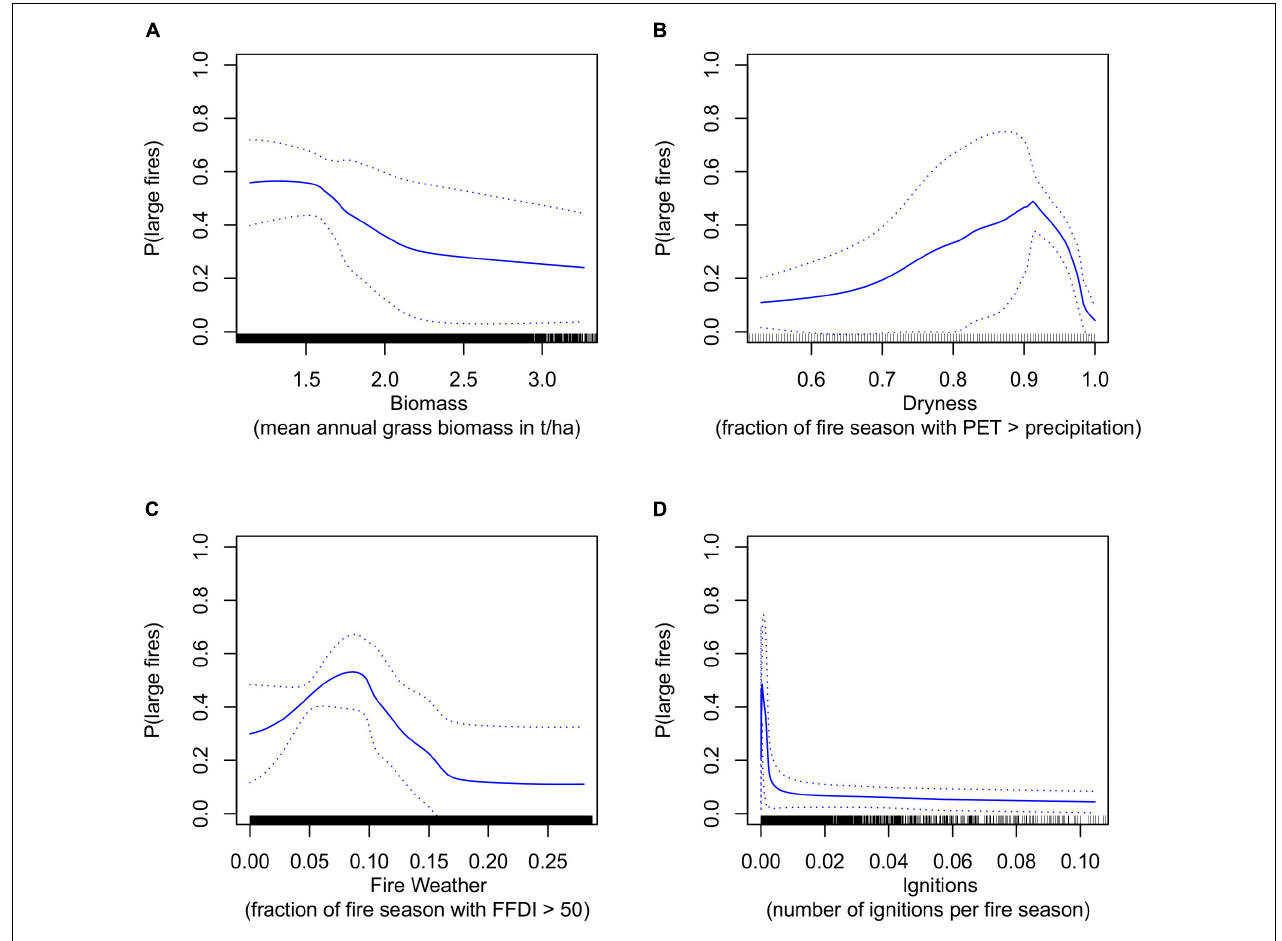
FIGURE 3 | As for Figure 2 , but for grasslands. X axis units are: (A) mean annual grass biomass in t ha − 1 ; (B) proportion of the fire season where PET > precipitation; (C) proportion of the fire season where FFDI > 50; (D) number of ignitions per fire